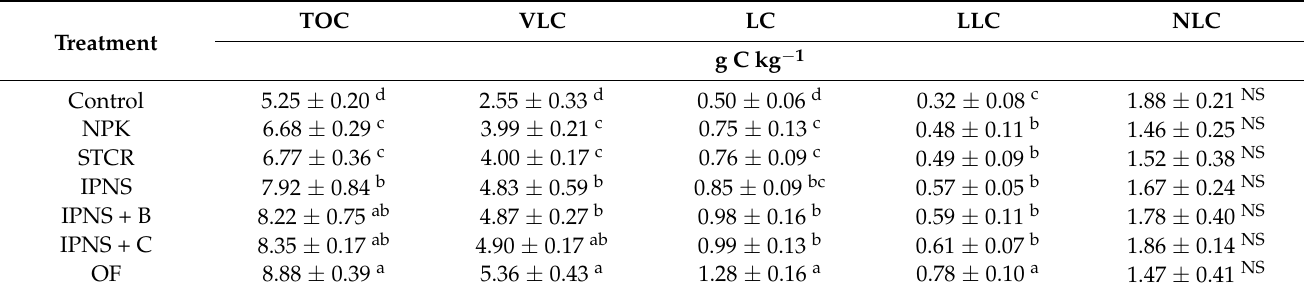
Table 1. Effect of nutrient management on soil C fractions (0–15 cm) under rice-wheat production system. Means ± standard deviation of different treatments followed by the different lower-case letter (a–d) are significantly different at p < 0.05 level of significance according to DMRT, NS—non significant.